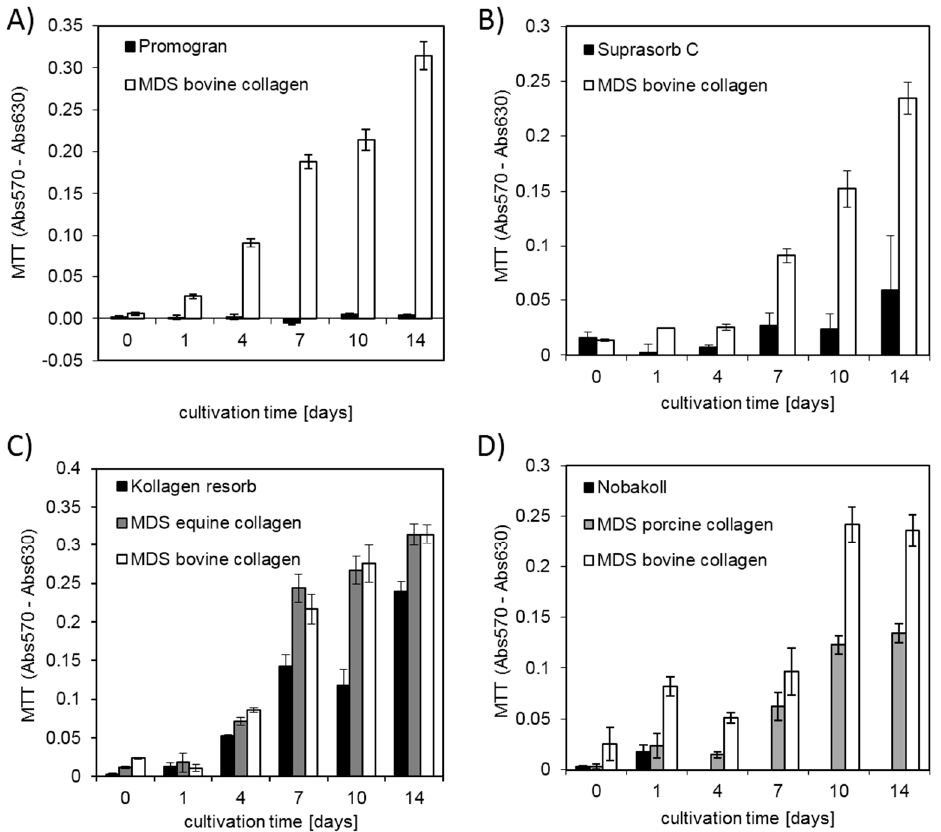
Figure 4. MTT absorbance values (absorption at reference wavelength and blanks subtracted) for up to two weeks of cell culture on different collagen matrix materials. ( A , B ) Bar charts for bovine collagen scaffolds of 15 mm and 6 mm diameters, respectively. Data of equine and porcine materials is shown in ( C , D ), respectively. Both ( C , D ) contain additional measurements of MDS bovine collagen for comparison between the different tests.